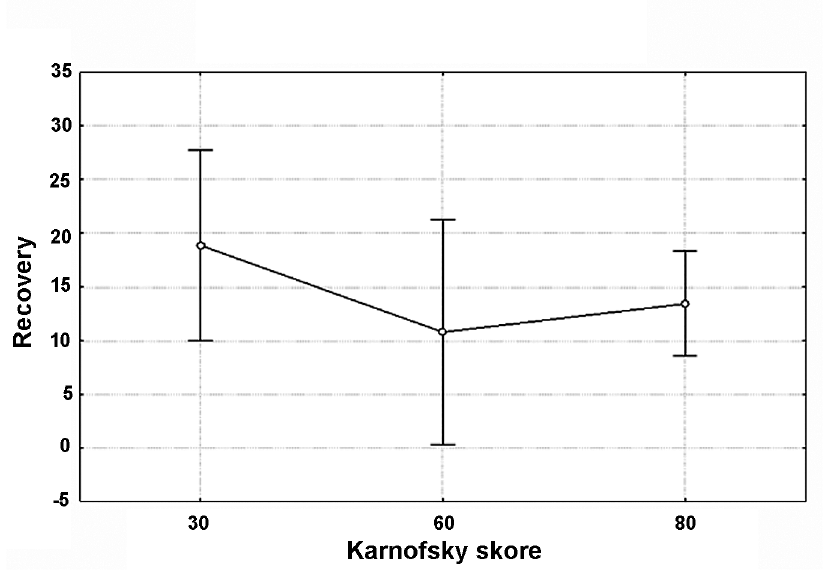
Figure 1 – One way ANOVA with Tuckey correction for multiple comparisons. Patients with a lower preoperative Karnofsky index exhibited a slight but insignificant tendency to a prolonged recovery